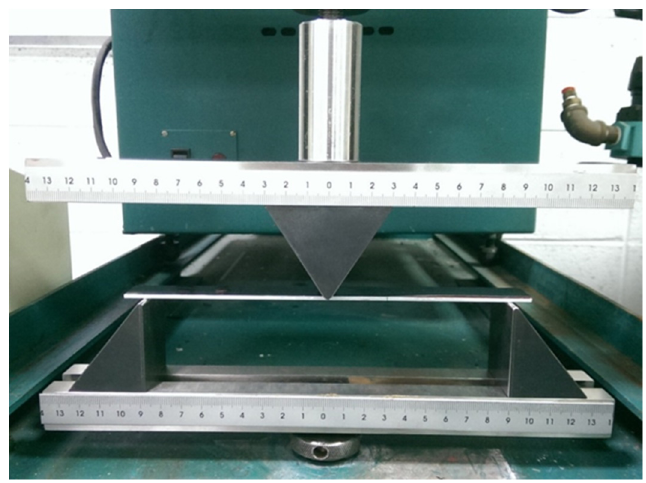
Figure 9. Three-point bending experimental test.